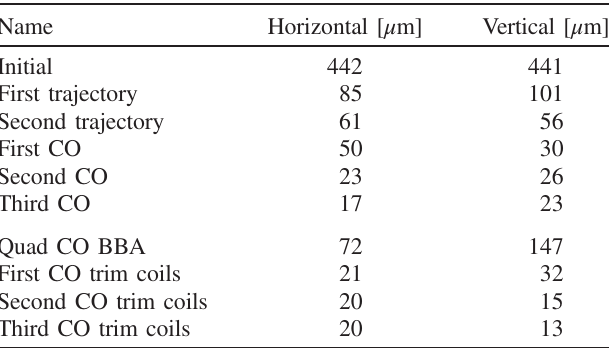
TABLE VIII. BBA results throughout the commissioning simulation for BPMs paired with quadrupoles (upper table) and chromatic sextupoles (lower table). Shown are the BPM offsets with respect to the corresponding magnet centers after various BBA